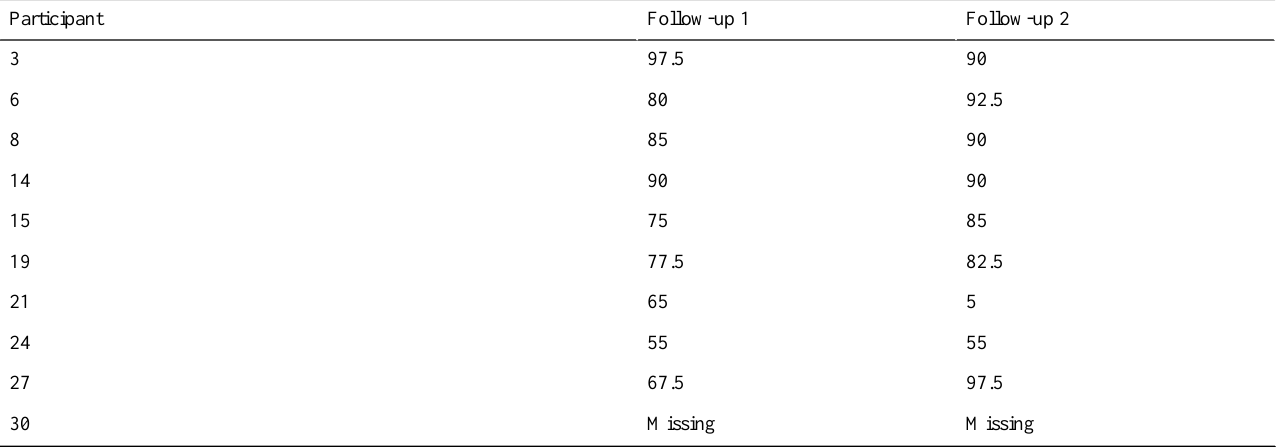
Table 6. Individual intervention participants’System Usability Scale scores at Follow-up 1 and Follow-up